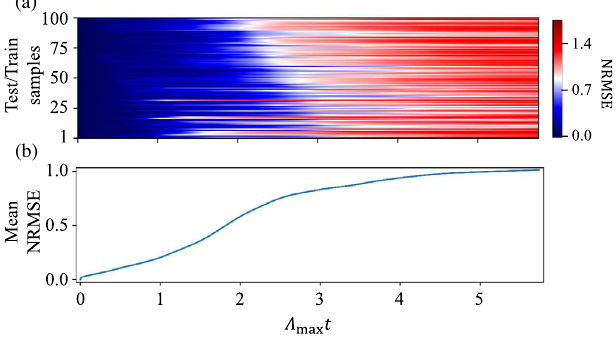
FIG. 4. (a) Normalized root mean square errors (NRMSE) calculated for 100 sets of training and testing KS datasets having the same parameters of the problem as in Fig. 3. (b) The mean NRMSE as a result of averaging (a) along its vertical axis.